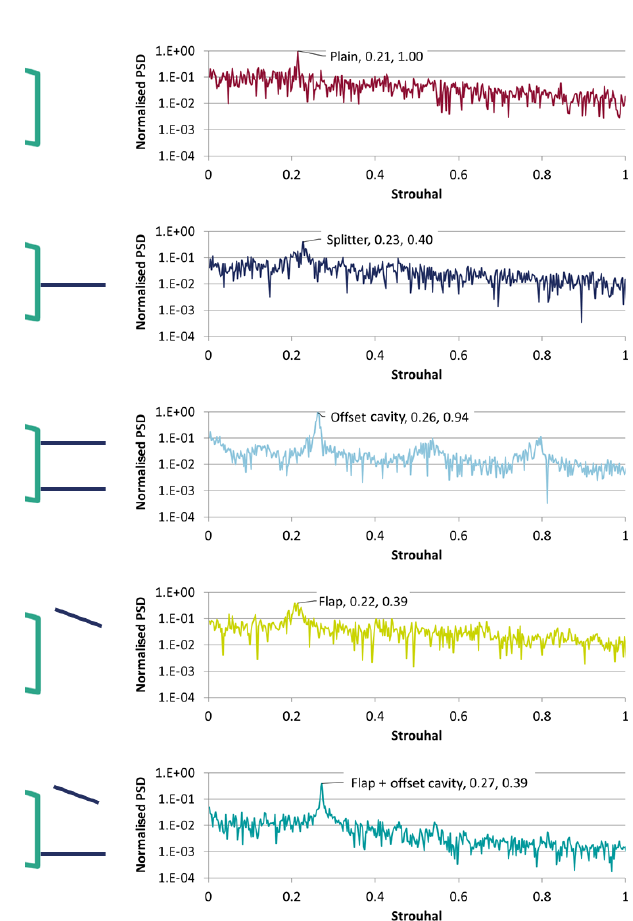
Figure 6. Normalised power spectral density of the velocity time series for the plain airfoil and all the TE device cases from fine IDDES simulations. The vertical velocity is considered at ( x,y ) = (1 . 57 c, 0); see also Fig. 2. Strouhal number is defined based on the trailing edge thickness, St = f h TE /V ∞